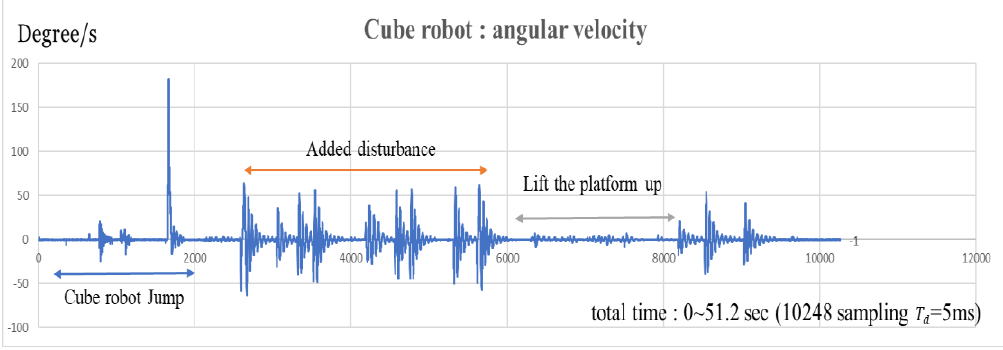
Figure 20. Time response of the tilt angle angular velocity 𝜃̇ 𝑃 of the cube robot bouncing and balancing on its edge.